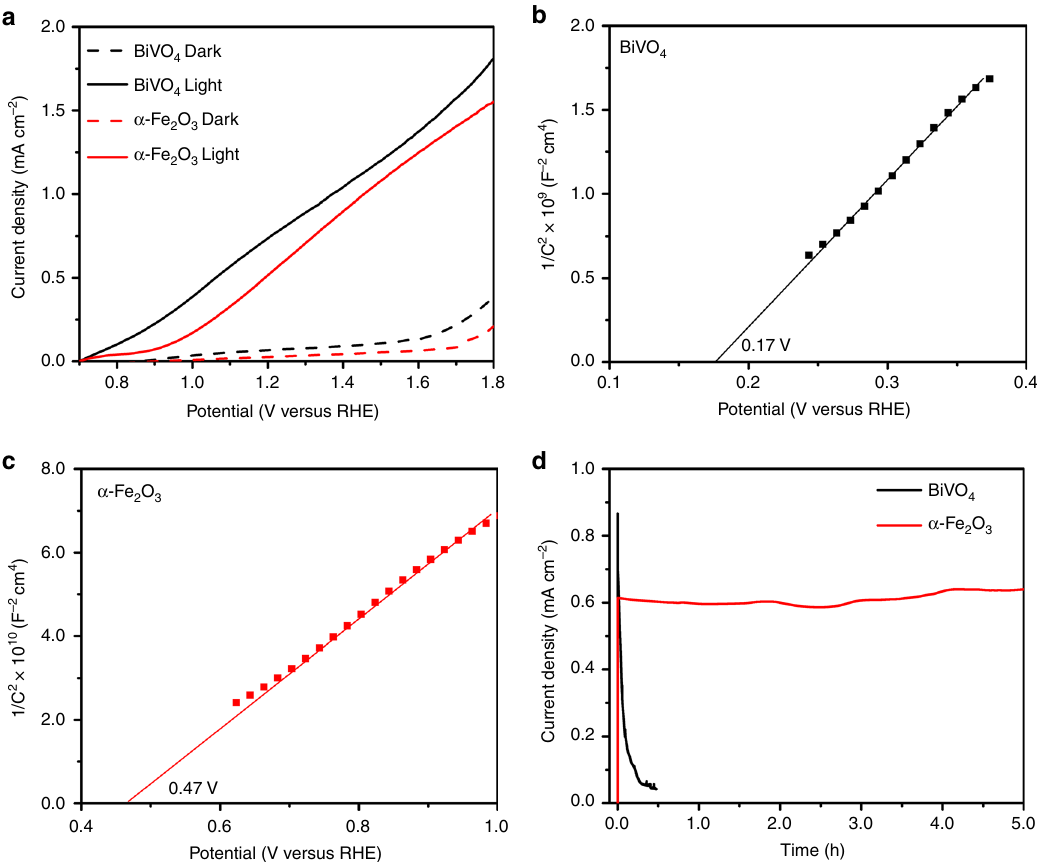
Fig. 3 Photoelectrochemical performance of the photoelectrodes. a Current density – potential curves of BiVO 4 and α -Fe 2 O 3 measured in 1 M KOH (pH = 13.6) in the dark and under AM 1.5 G, 100 mWcm – 2 illumination. Mott – Schottky plots of the b BiVO4 and c α -Fe 2 O 3 at an AC frequency of 1 kHz in the dark. d Current density – time curves of the BiVO 4 and α -Fe 2 O 3 photoelectrodes under illumination at 1.23 V vs.